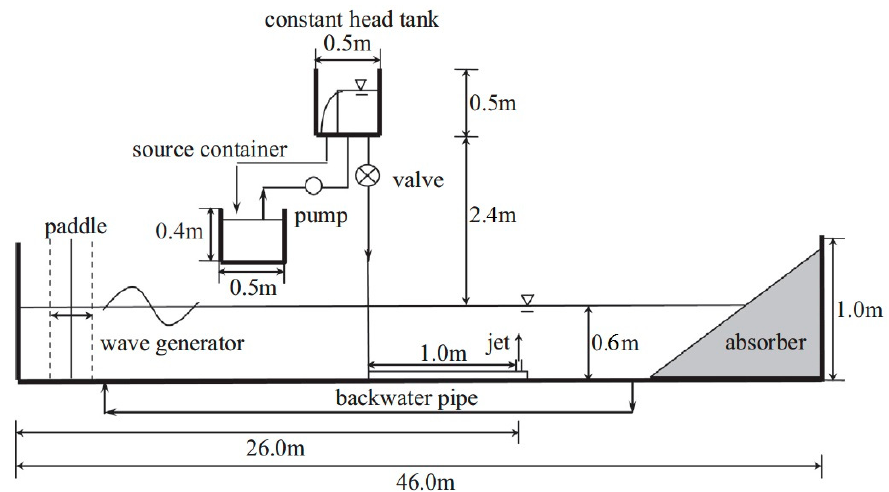
Figure 3. Schematic design of the experimental setup (modified from the diagram of Xu et al. [28]).